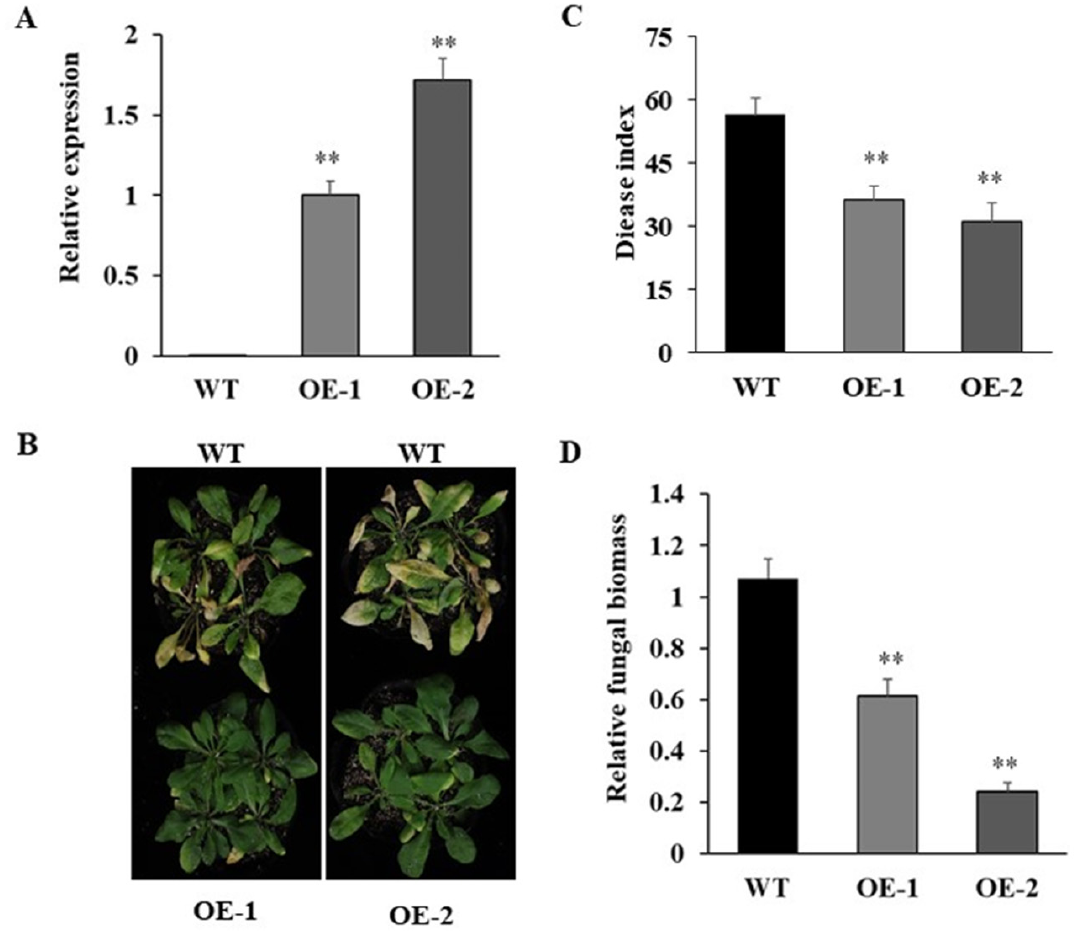
Figure 7. GhPRA1.B1-1A overexpression increased V. dahliae resistance in A. thaliana . ( A ) The transcrip-